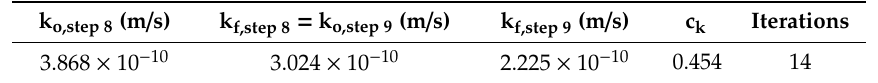
Table 11. Fourth application. c k and initial and final hydraulic conductivities for loading steps 8 and 9.